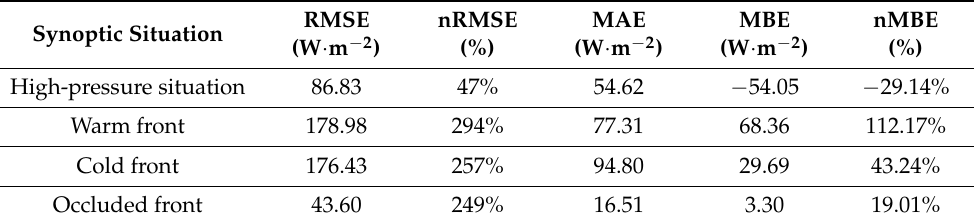
Table 8. Error values: RMSE, nRMSE, MAE, MBE, nMBE for individual synoptic situations (RRTMG).